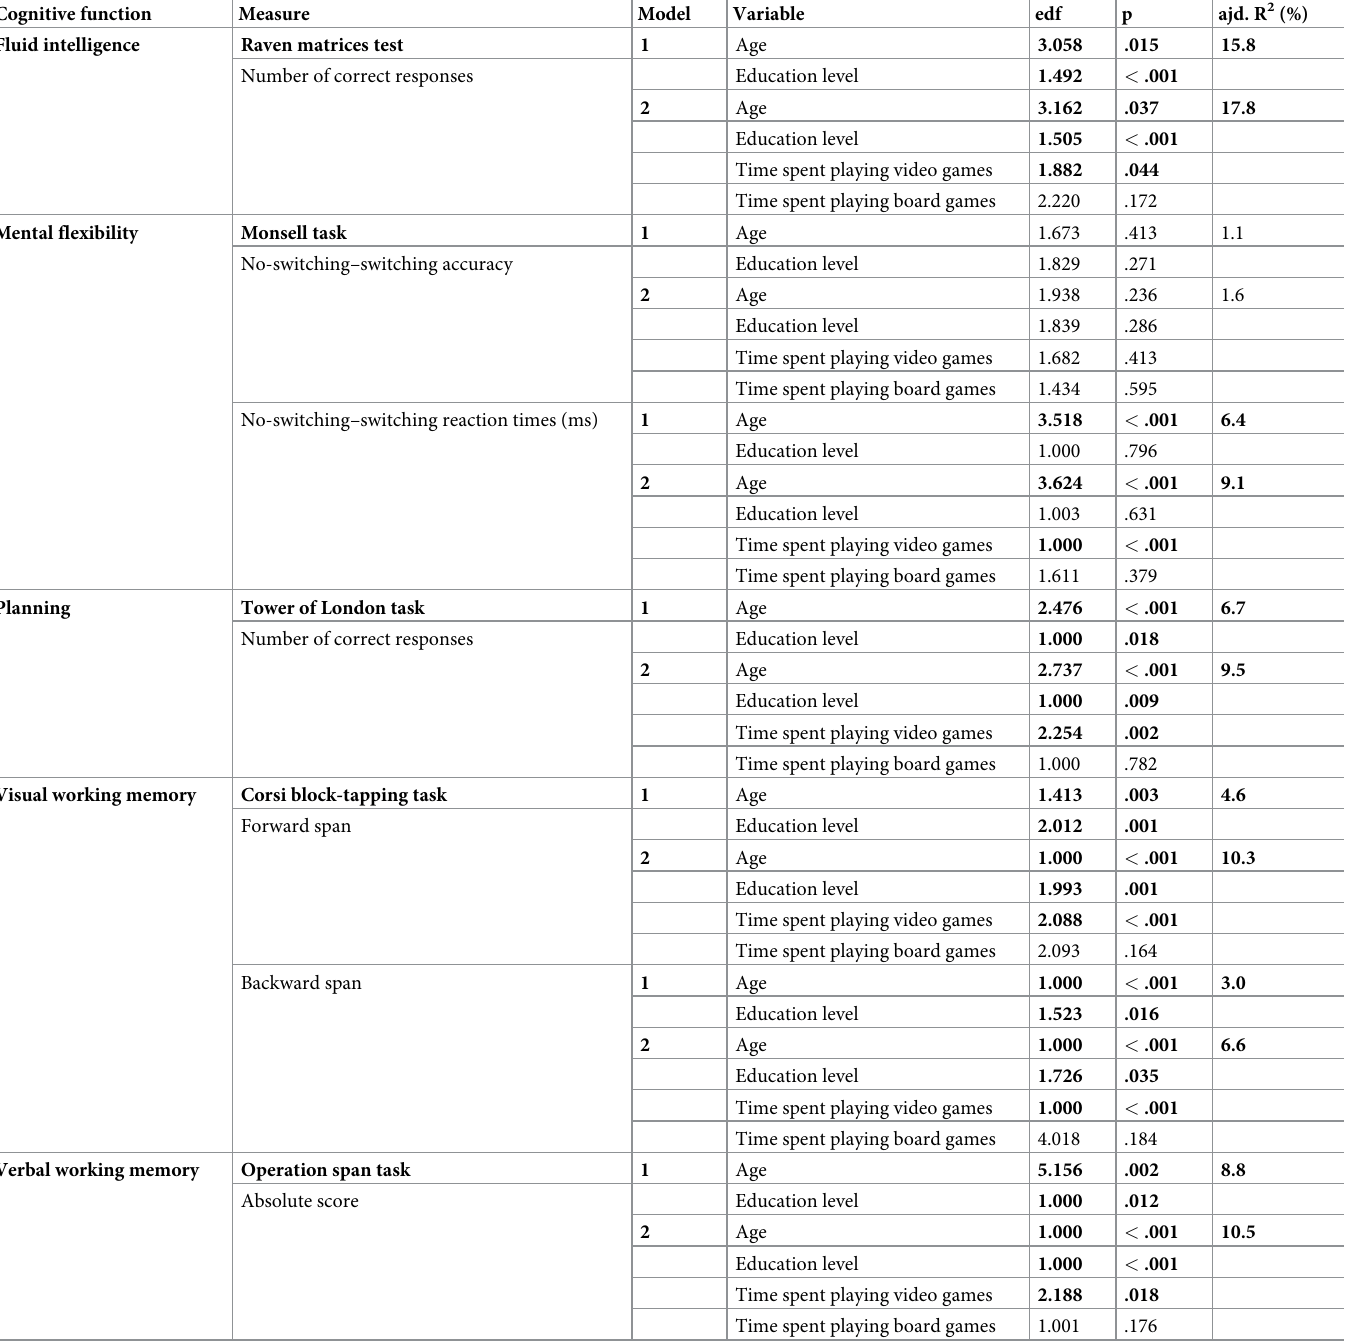
Table 2. Results of the multivariate GAMs for game-specific play times. Cognitive